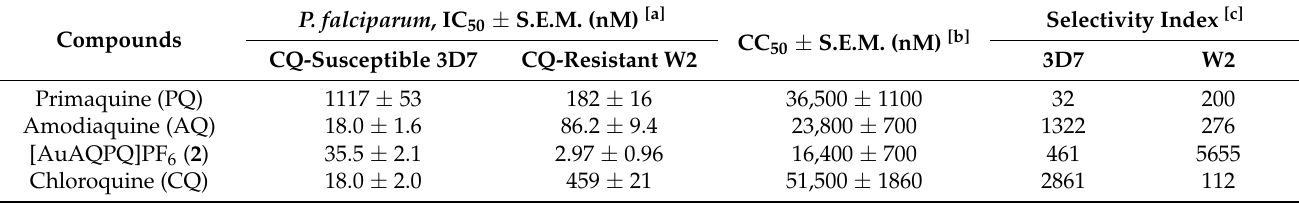
Table 1. In vitro activity of compounds against the asexual blood stages of P. falciparum , cytotoxicity for mammalian cells and the selectivity